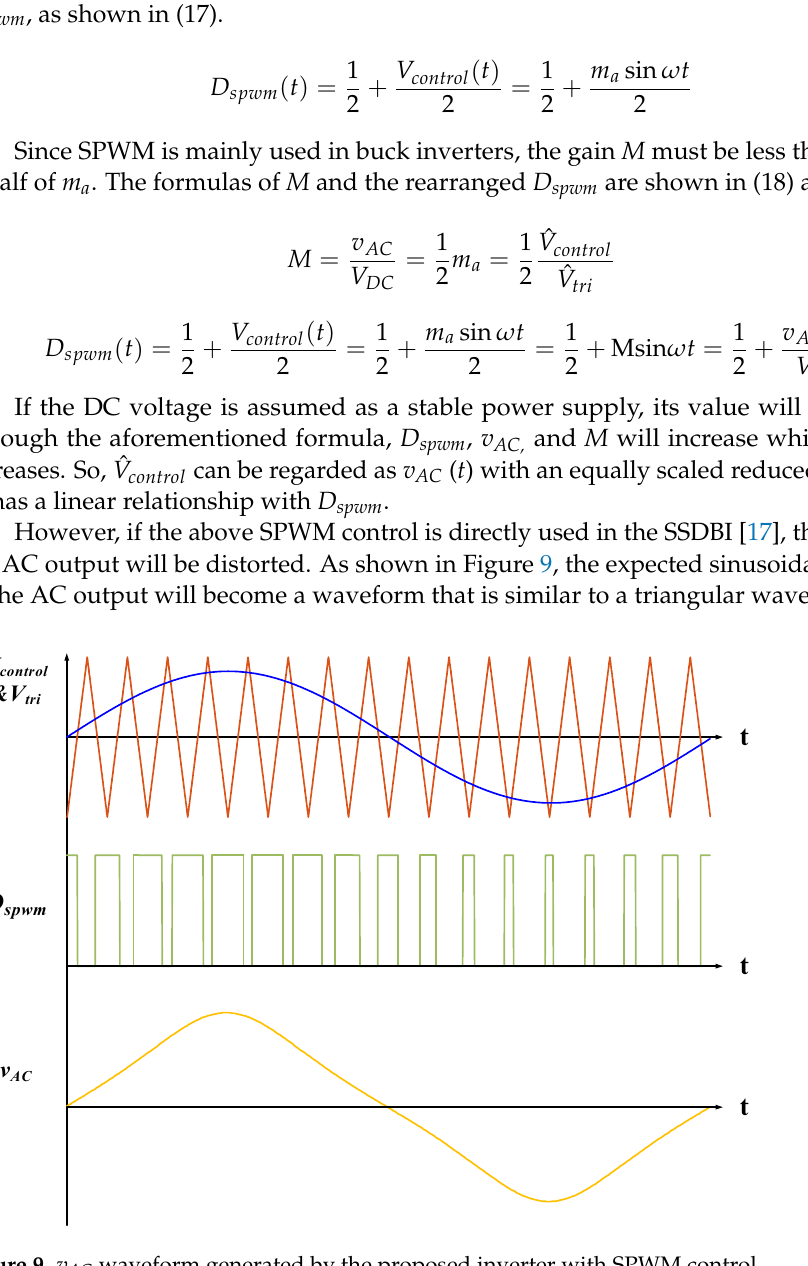
Figure 9. v AC waveform generated by the proposed inverter with SPWM